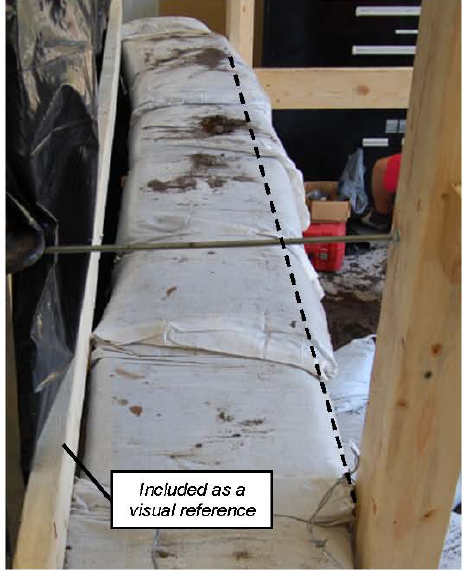
Figure 9. Permanent wall displacement as observed during wall deconstruction.